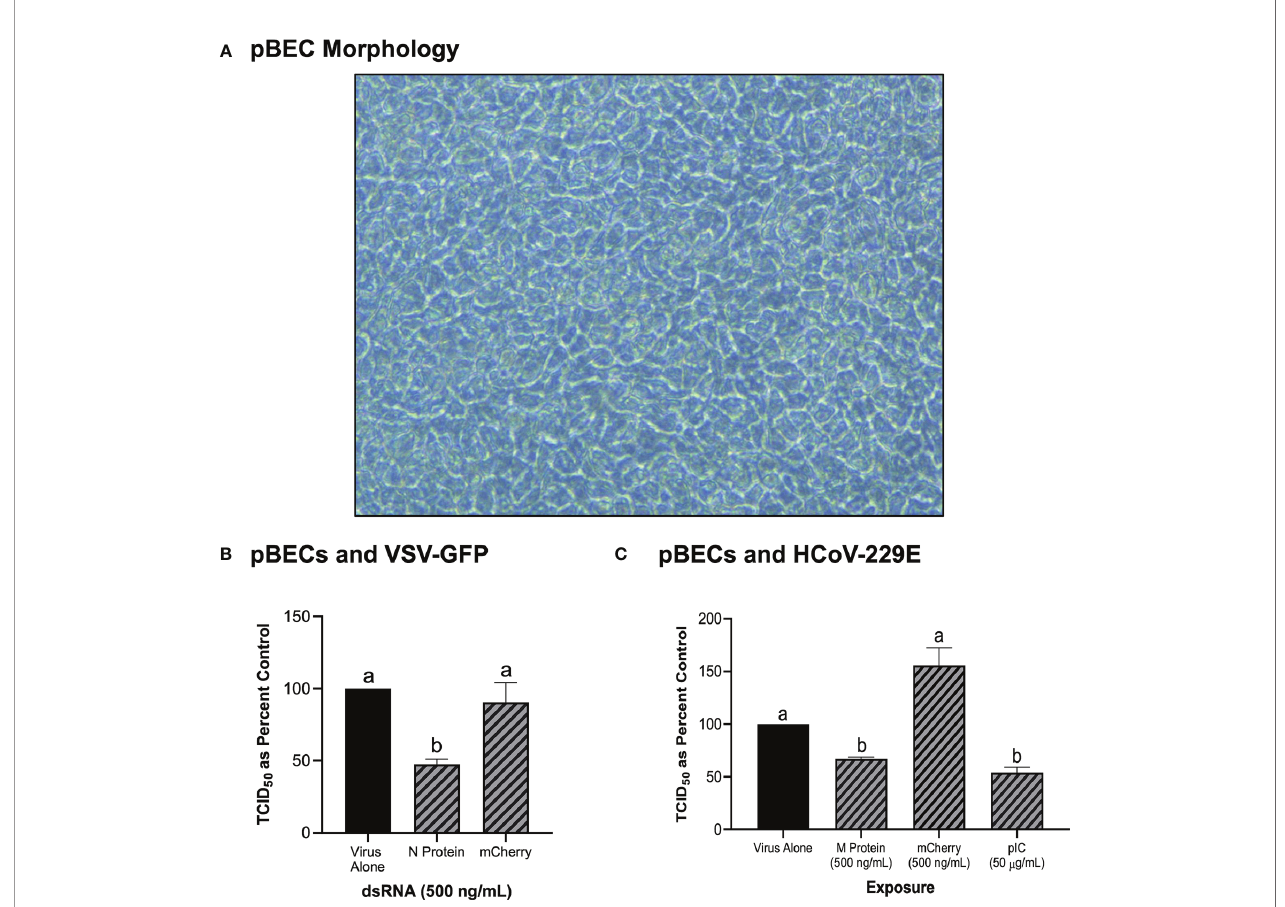
FIGURE 5 | Primary Bronchial Epithelial/Tracheal Cells (pBECs) pre-soaked with long dsRNA of viral genes inhibits infection with corresponding viruses. The pBECs were grown to con fl uence and were shown to exhibit characteristics indicative of epithelial/tracheal cells, including mucous production and cilia function (A) . The pBECs were pre-soaked with either DPBS, 500 ng/mL of the mis-matched mCherry dsRNA control or 500 ng/mL of VSV N protein dsRNA before infection with VSV-GFP (MOI = 0.1) for 24h (B) . The pBECs were also pre-treated with either DPBS, 50 m g/mL of HMW pIC, 500 ng/mL of the mis-matched mCherry dsRNA control or 500 ng/mL of HCoV-229E M protein dsRNA before infection with HCoV-229E (MOI = 0.1) for 24h (C) . Error bars represent +SEM, and each data point represents the average of 3 independent replicates. A p-value of less than 0.05 was considered to be statistically signi fi cant. Error bars with different letters represent signi fi cantly different